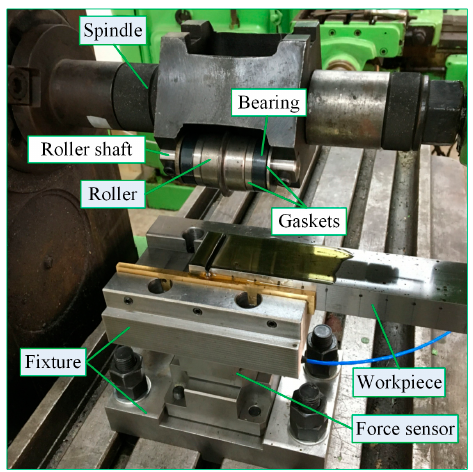
Figure 3. CRBF experimental equipment.